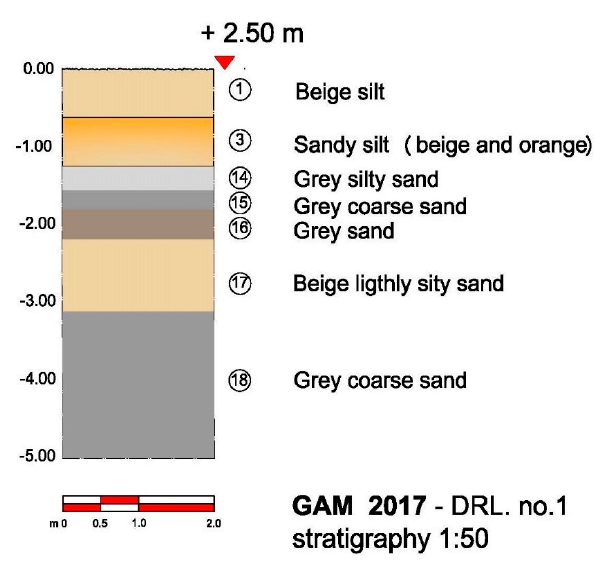
Figure A1. Graphic depiction of drilling No. 1 in 2017 in Lago Tramonto, Gambulaga, Portomaggiore (FE, Italy).